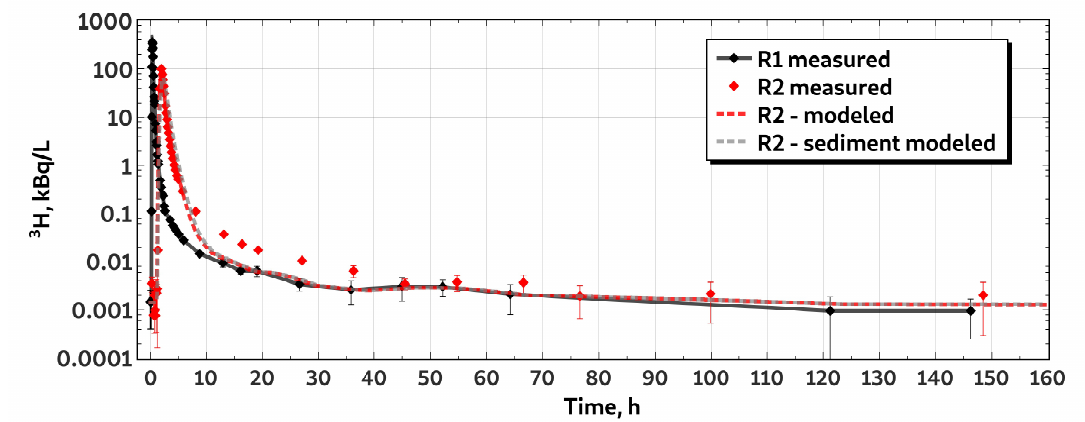
Figure 6. The 3 H activity concentrations observed at R1 and R2, and modeled at R2. Values of model parameters: α = 3.2 × 10 − 5 [1/s], A s = 0.099 [m 2